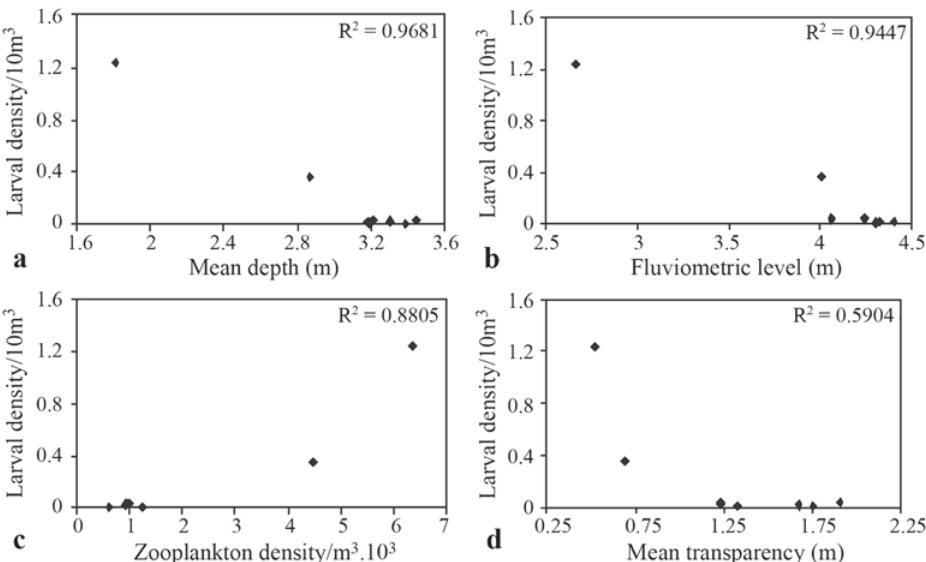
Fig. 6. Correlation of the mean density of fish larvae with: (a) Mean depth of the lagoons during the sampled periods; (b) Fluviometric level of the Cuiabá River during those periods; (c) Mean zooplankton density during those periods; and (d) Mean water transparency of the lagoons during the sampling periods.